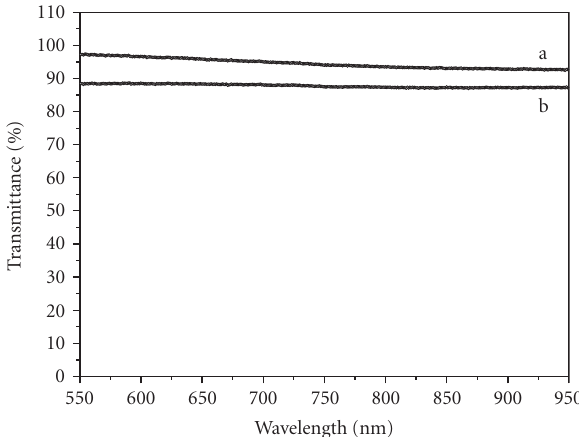
Figure 5: Transmittance of (a) pure PEDOT:PSS and (b) M- PEDOT:PSS (0.1wt%) films.